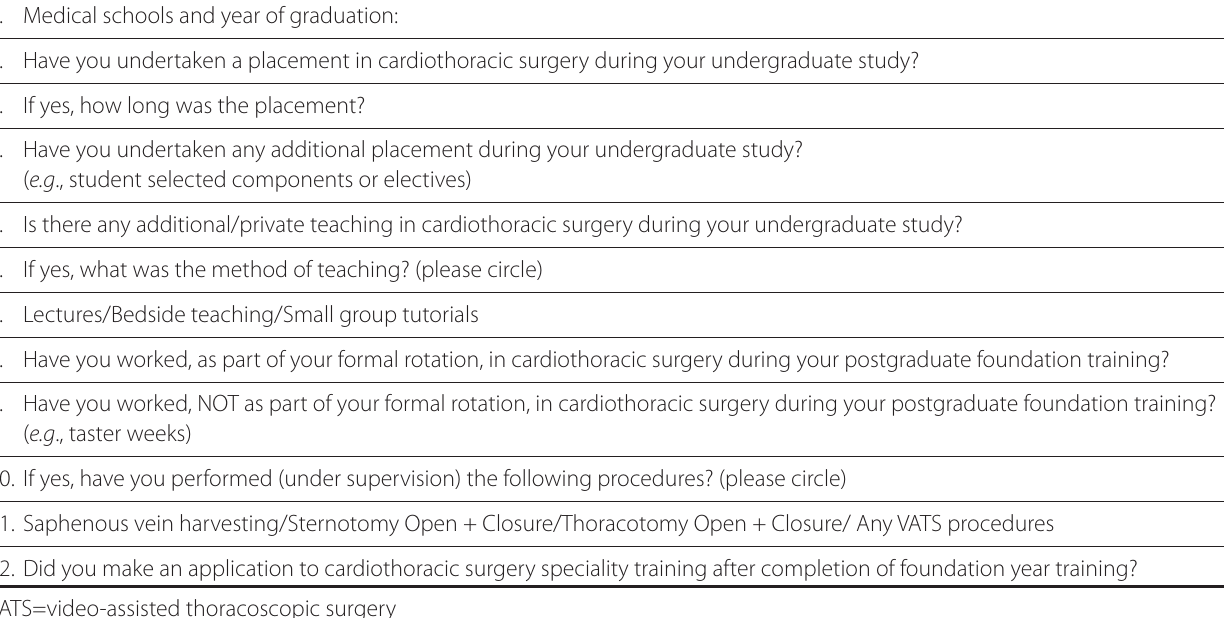
Table 1 . Ten-question